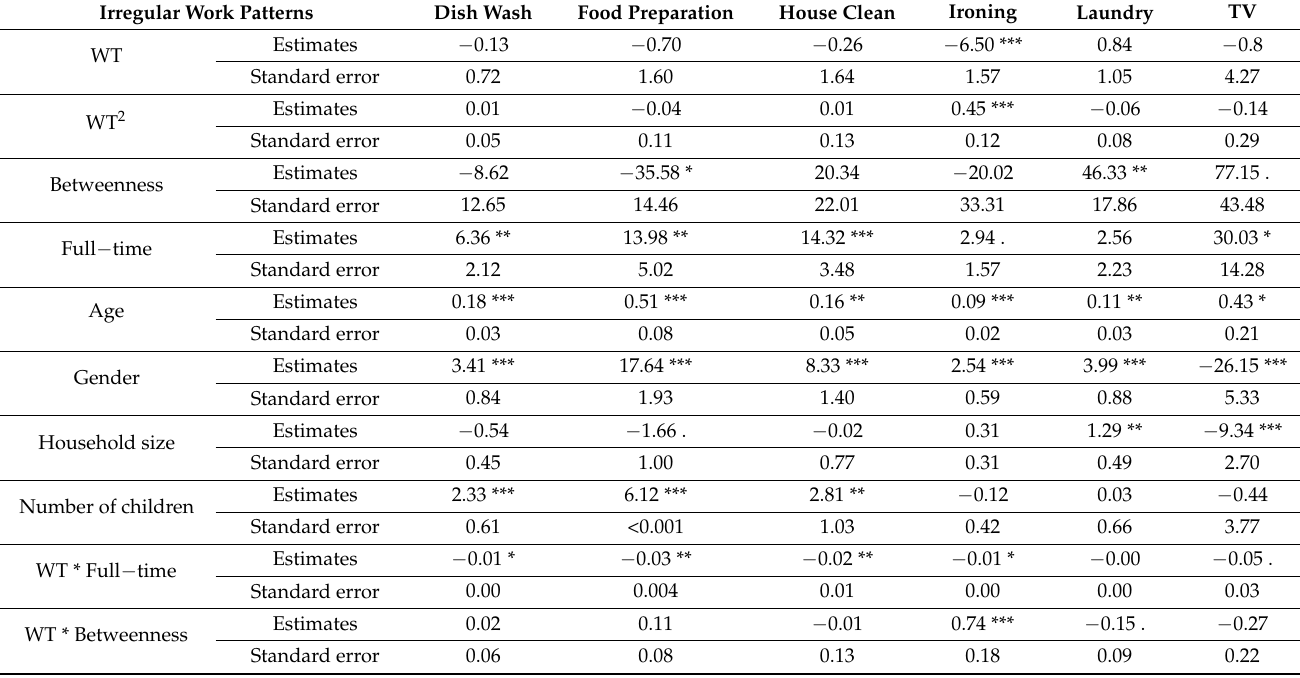
Table 5. The marginal effect of irregular work patterns on time